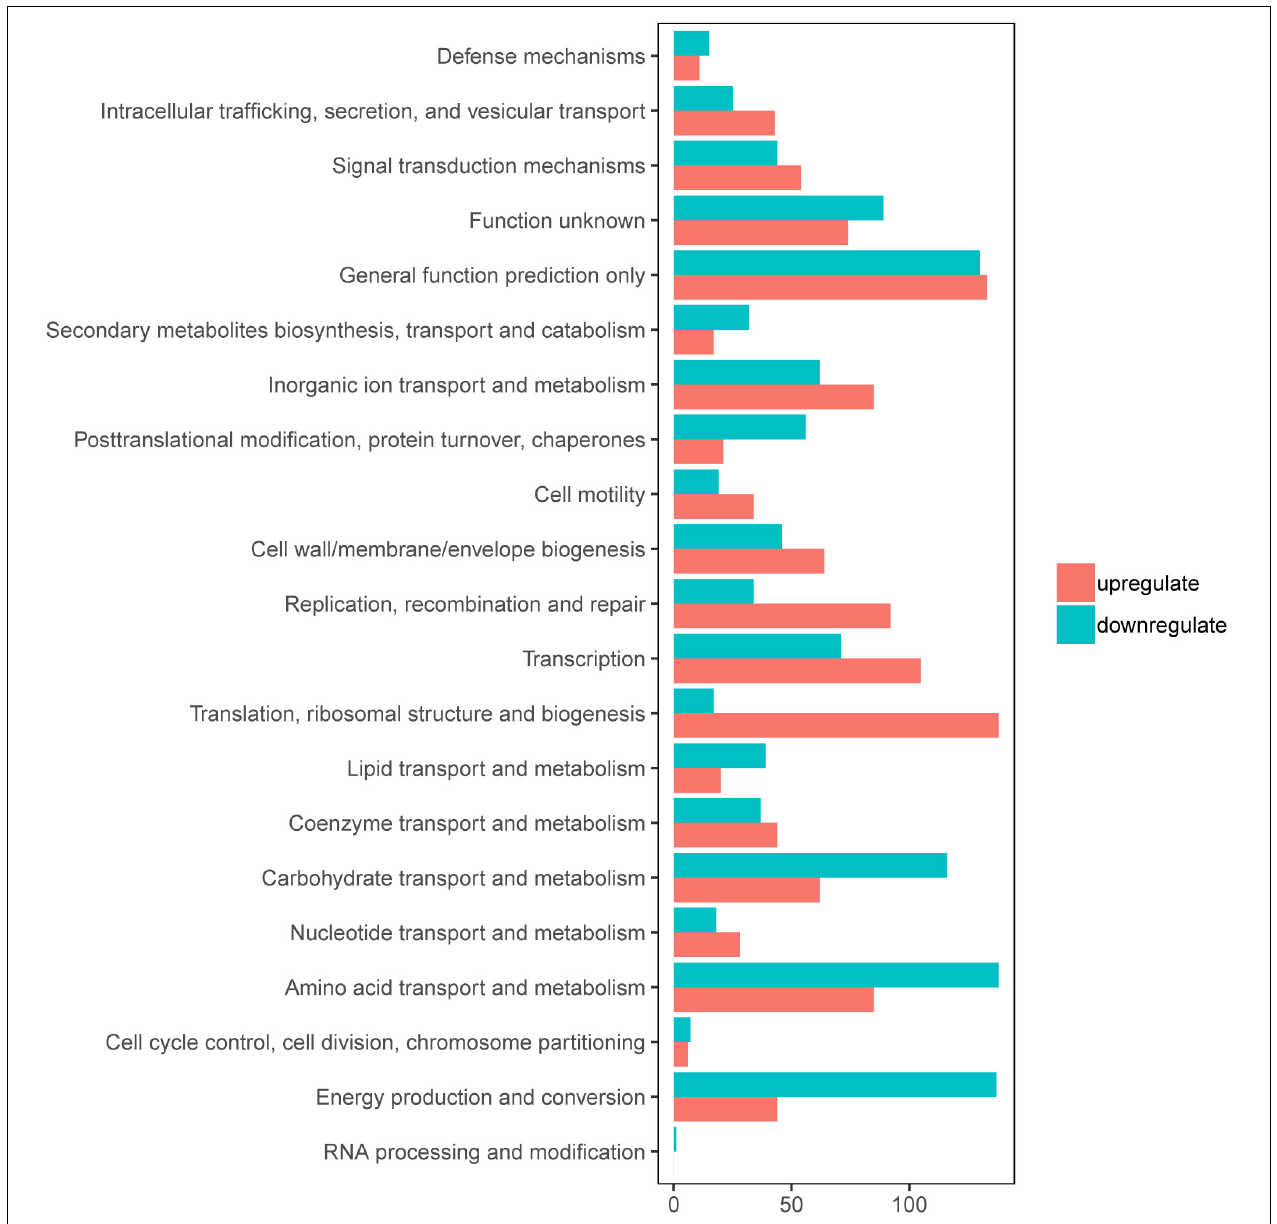
FIGURE 1 | Clusters of orthologous groups (COGs) analysis of differentially expressed genes (DEGs) in E. coli CFT073 after 8 h of invasion of the 5637 bladder cell line. Red bars indicate upregulated genes, while blue bars indicate downregulated